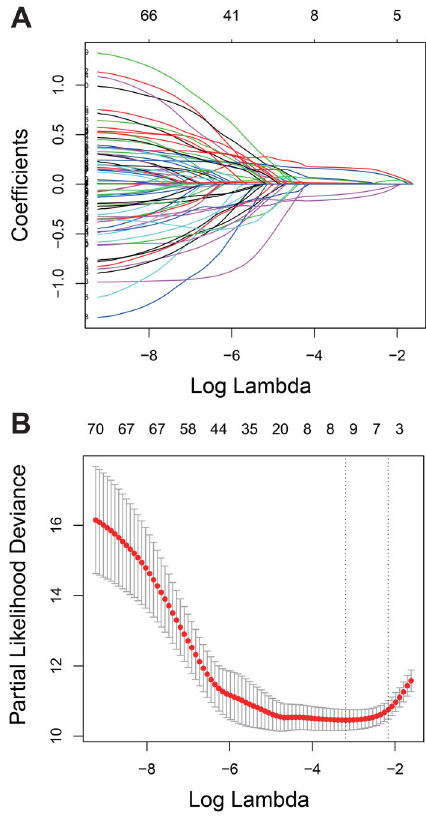
Figure 2. Establishment of prognostic gene signature by LASSO regression analysis. A , LASSO coef fi cient pro fi les of the 72 genes in the training cohort. B , Coef fi cient pro fi le plot was generated against the log (lambda) sequence. Selection of the optimal parameter (lambda) in the LASSO model for training cohort. LASSO: least absolute shrinkage and selection operator Cox regression